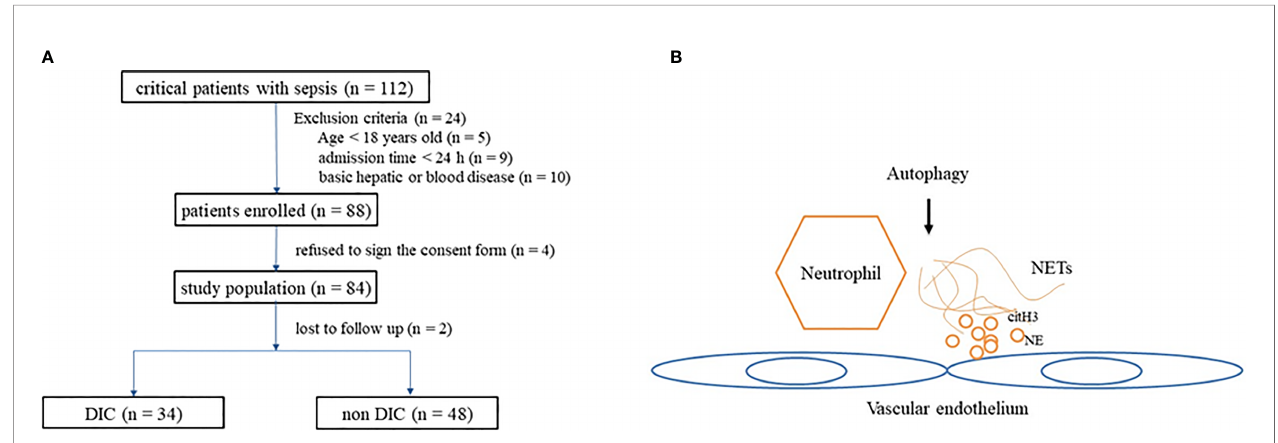
FIGURE 1 | (A) Flowchart of patients included in the study. (B) Diagram depicting interaction of autophagy in fl uence NETs and endothelium. NETs, neutrophil extracellular